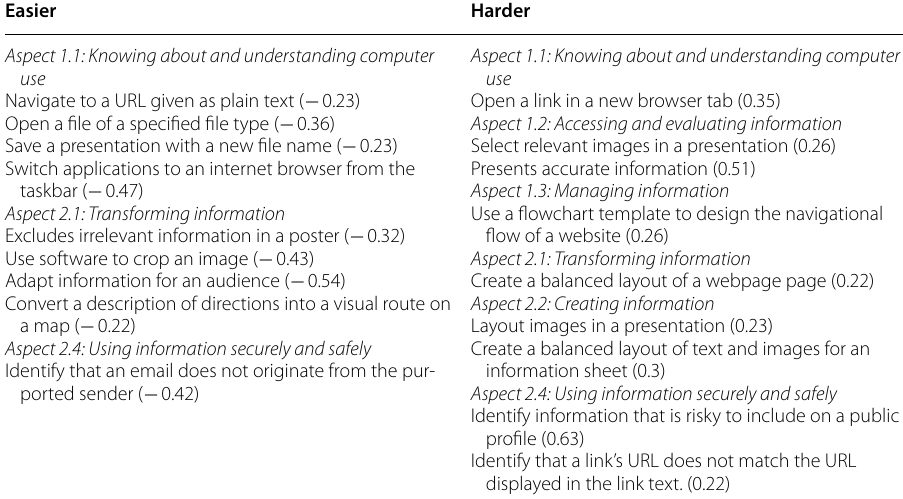
Numbers in parenthesis are the DIF values